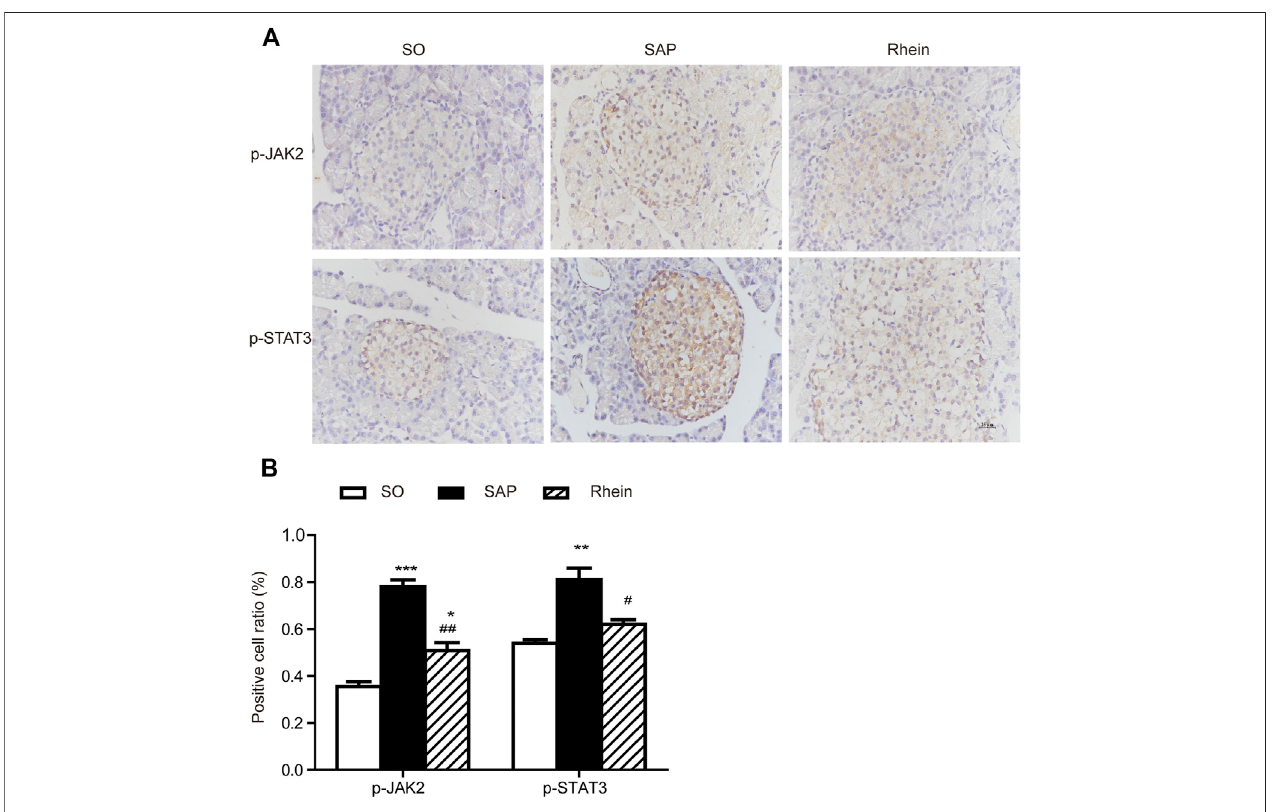
FIGURE 5 | Immunohistochemical analysis of p-JAK2 and p-STAT3 in pancreatic tissues. (A) Representative immunohistochemistry images of p-JAK2 and p-STAT3 in pancreatic tissues 24 h after the induction of SAP; Scale bar: 25 μ m. (B) Positive cell ratio of pancreatic tissue sections. Data are expressed as mean ± SD ( n = 3 per group). Signi fi cance between groups was evaluated by one way analysis of variance (ANOVA) followed by a Tukey post hoc test. * p < 0.05, ** p < 0.01 and *** p < 0.001comparedwiththeSOgroup; # p < 0.05, ## p < 0.01and ### p < 0.001comparedwiththeSAPgroup.JAK2,januskinasetwo;STAT3,signaltransducer and activator of transcription three; SO, sham operation; SAP, severe acute